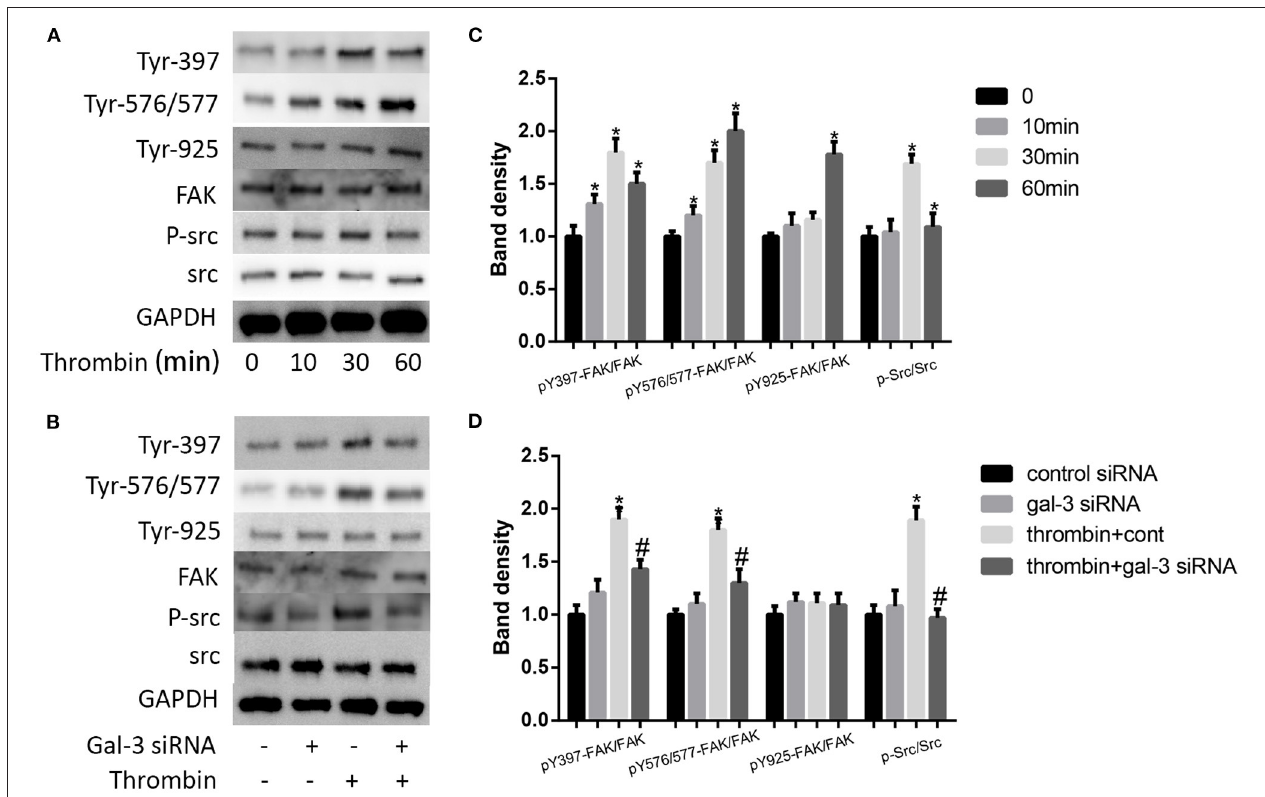
FIGURE 5 | Thrombin activated distinct FAK signalings via gal-3. VSMCs were treated with thrombin over a range of concentrations (2 U/ml) for different times (0, 10, 30, and 60min), and the expression of p-src and src, the phosphorylation of FAK at Tyr-397, − 576/577, and − 925, and FAK were measured by Western blot (A,C) . After transfection with either control or gal-3 siRNA for 24h, VSMCs were incubated for 30min in the absence or presence of thrombin (2 U/ml), and the expression of p-src and src, the phosphorylation of FAK at Tyr-397, − 576/577, and − 925, and FAK were measured by Western blot (B,D) . Quantification of the results is shown in the right panel. Band density of native VSMCs was defined as a control and considered to 1. * p < 0.05 vs. control; # p < 0.05 vs.